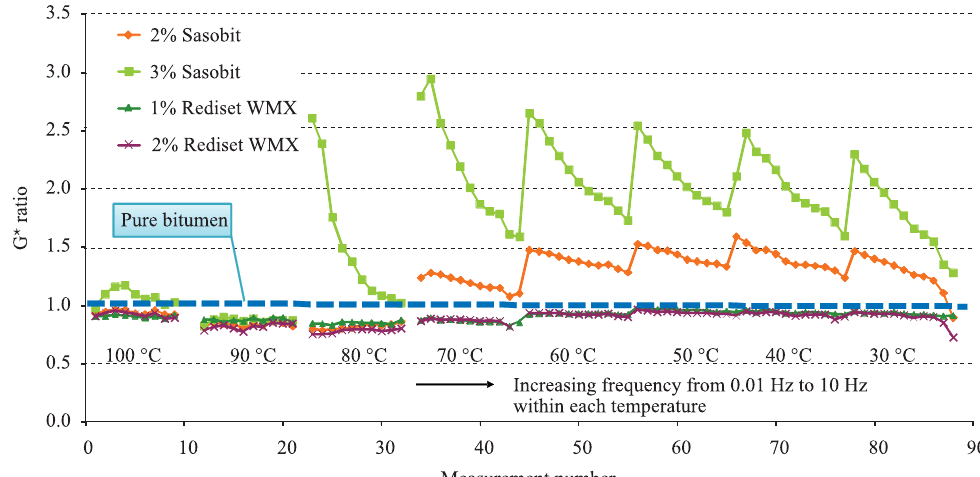
Fig. 3. Ratio of G* for the modified binders relative to pure